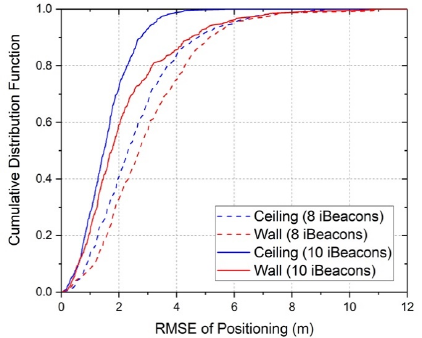
Figure 7. Cumulative distribution function (CDF) comparison of the two deployment methods using 8 and 10 iBeacons, respectively.